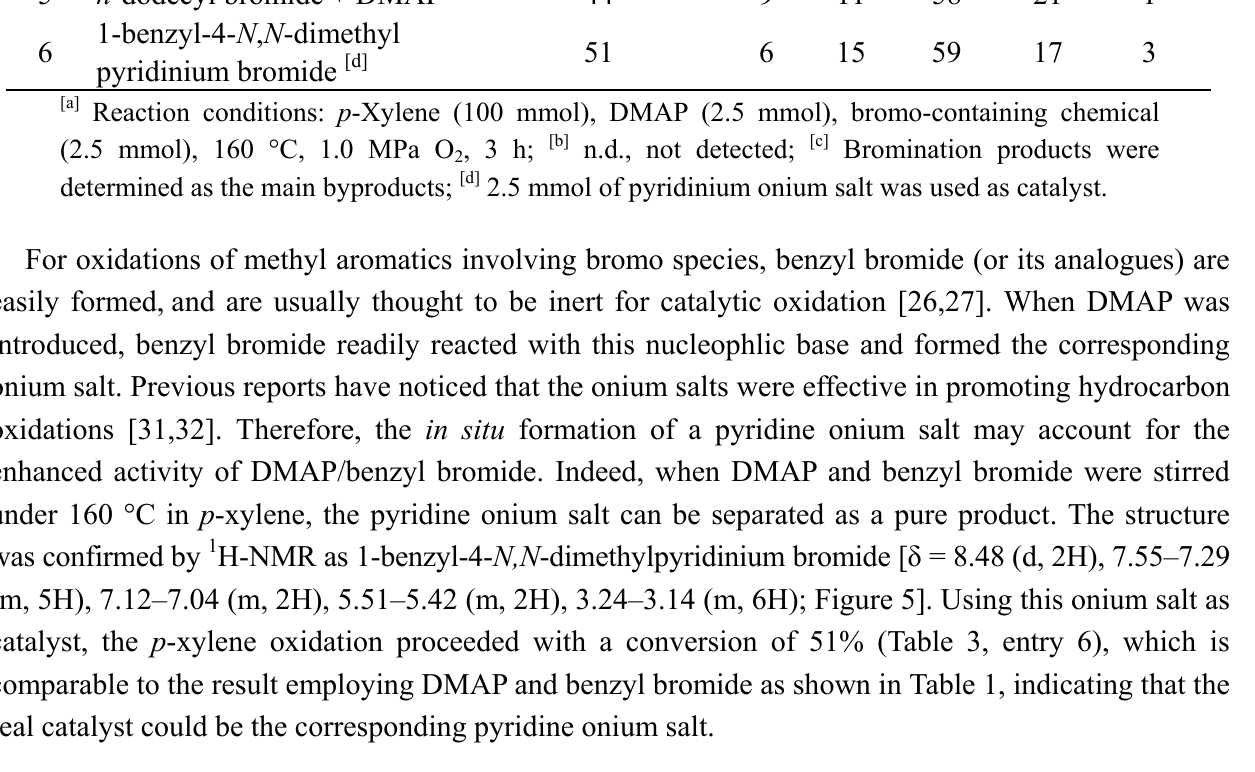
Figure 5. 1 H-NMR of the separated pyridine onium salt; the signal at 2.51 ppm is attributed to DMSO solvent residue, and that at 3.35 ppm is attributed to water existed in DMSO- d 6